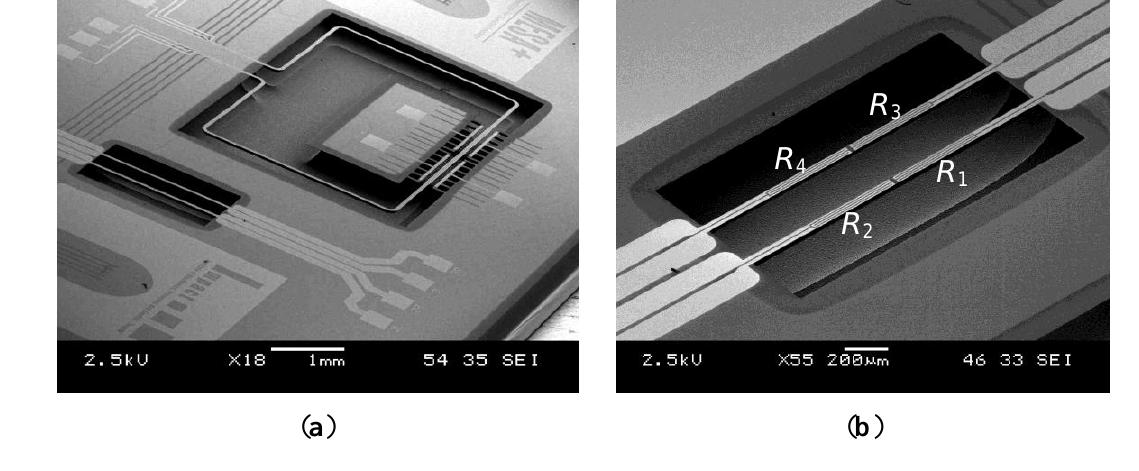
Figure 6. SEM photographs of the combined single chip thermal/Coriolis flow sensing system: ( a ) Overview of the chip, ( b ) thermal flow sensor and ( c ) Coriolis flow